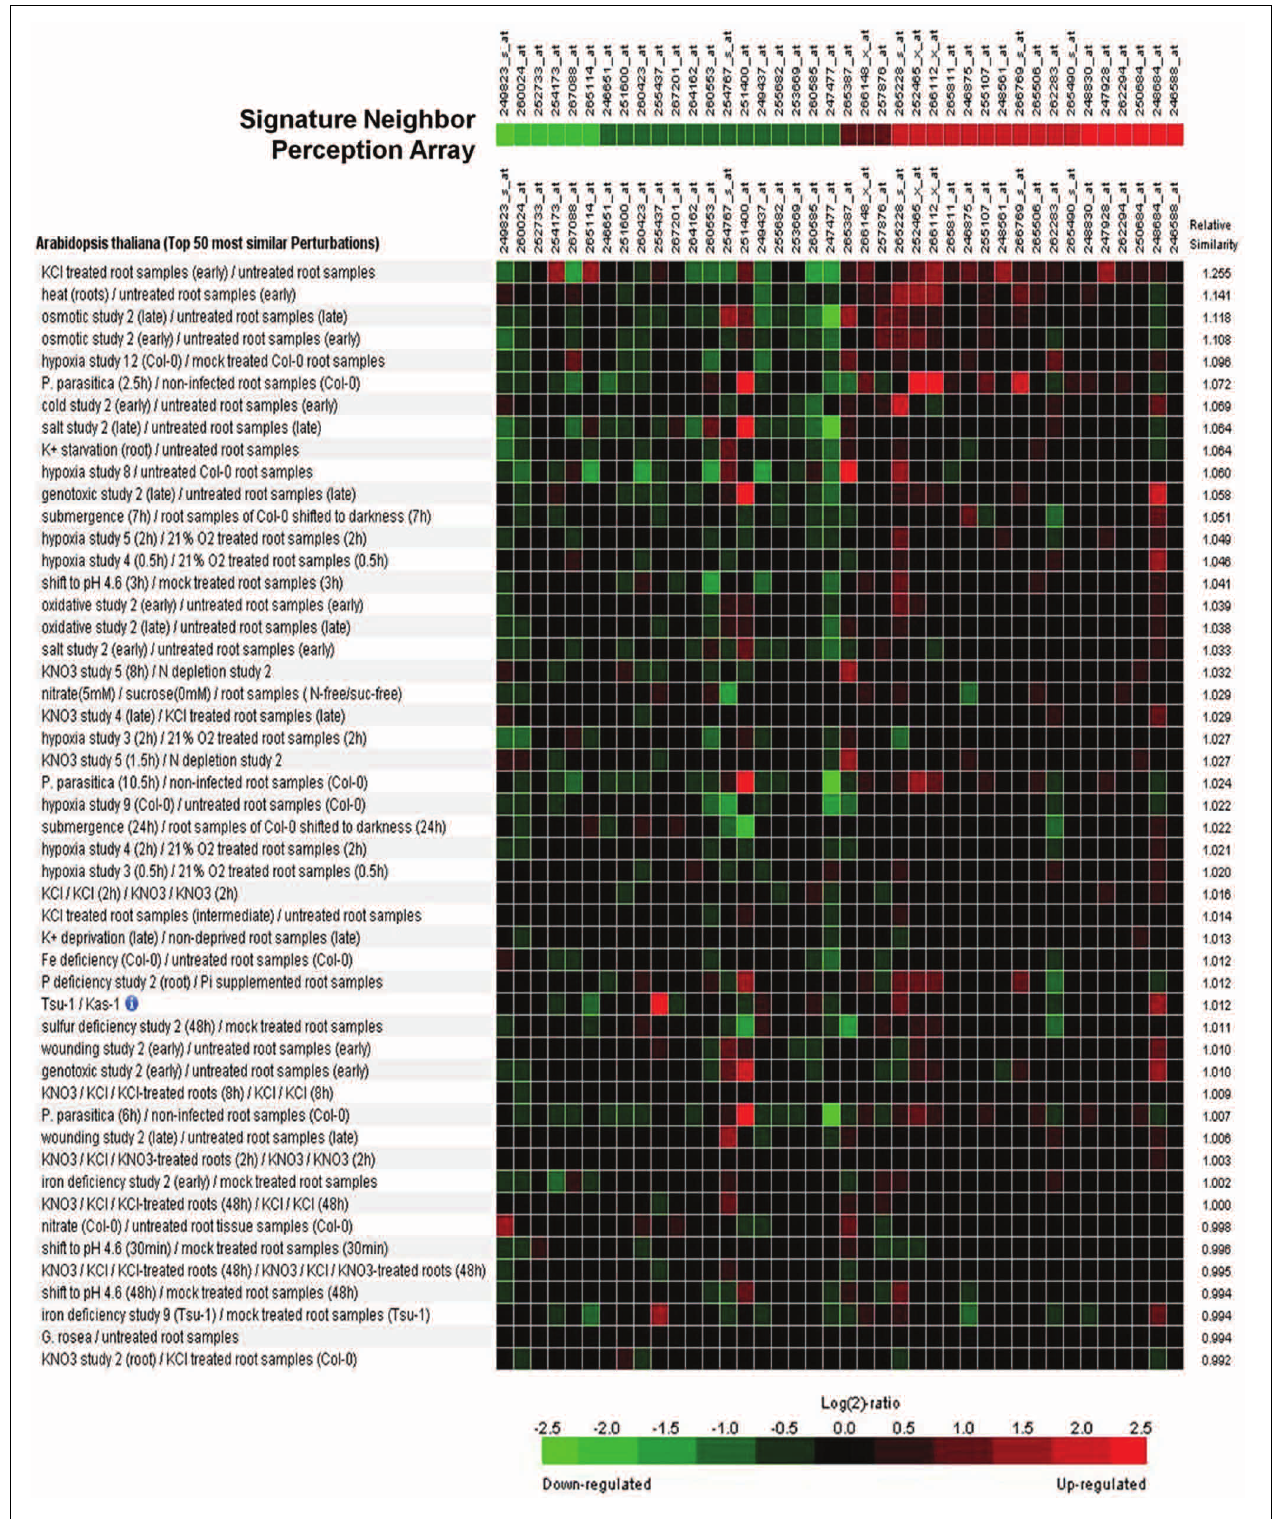
FIGURE 3 | Signature analysis between the neighbor-perception-microarray and transcriptome studies on various perturbations from the Genevestigator database. From the list of significantly altered gene-productswith at least two P-calls, the 20 genes with the highest and the 20 genes with the most negative induction factor